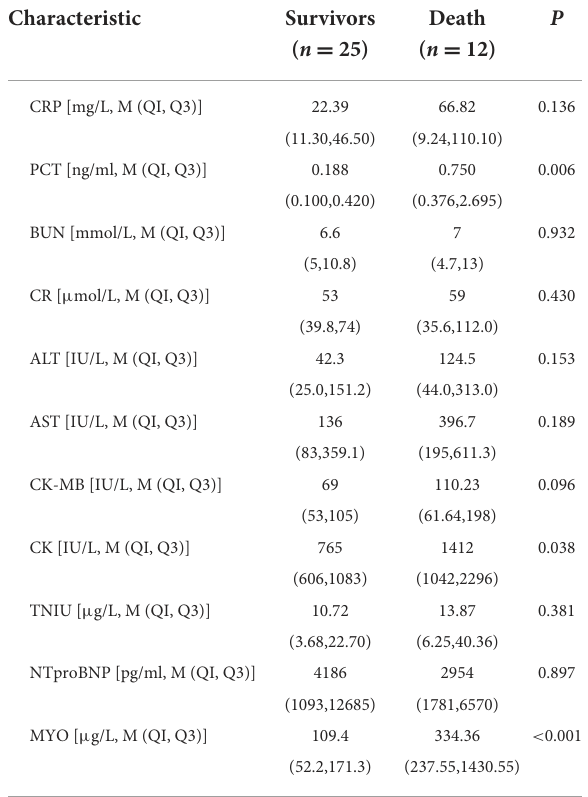
TABLE 2 Comparison of laboratory parameters in patients with